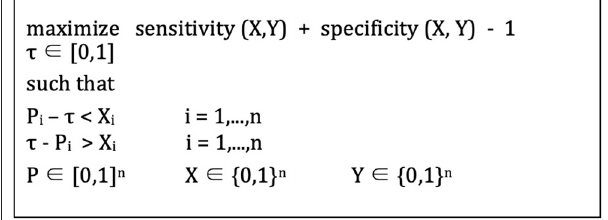
FIGURE 1 | Threshold optimization formulation.